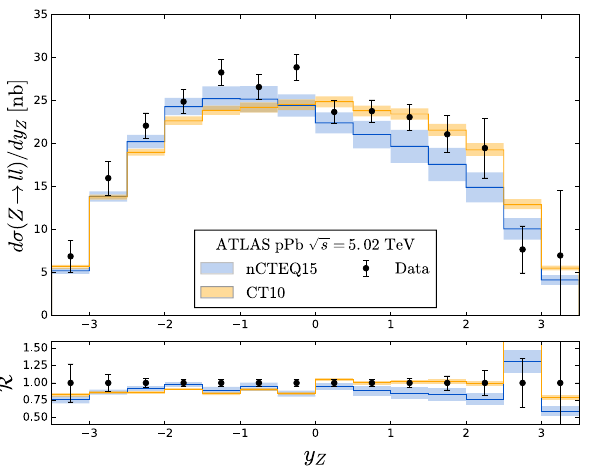
Fig. 4 CMS Z production in pPb collisions